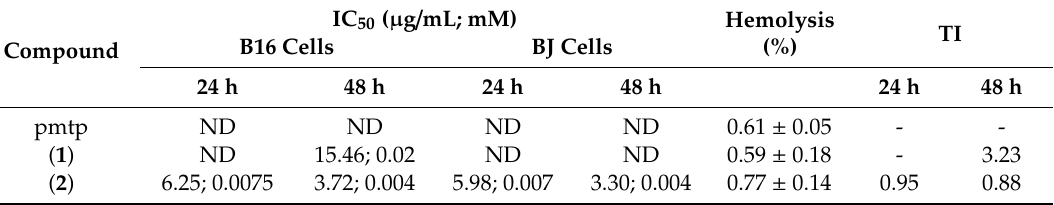
Table 5. The half-maximal inhibitory concentration (IC 50 ) and hemolysis data for compounds. IC 50 ( µ g / mL; Compound